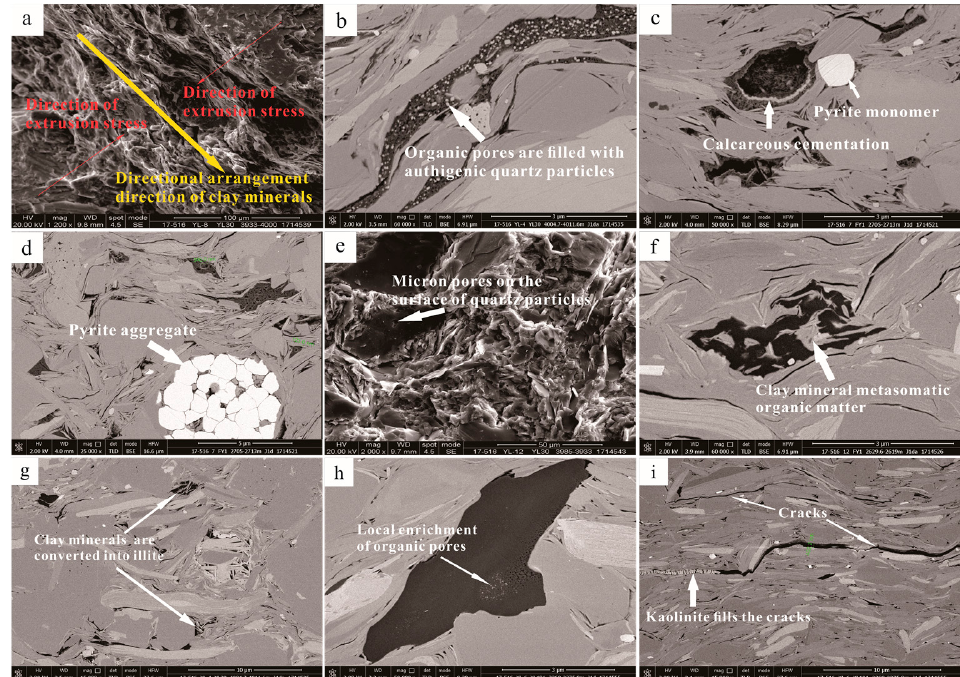
Figure 8. Scanning electron microscope microscopic characteristics of Da’anzhai shale diagenesis. ( a ) Compaction leads to a directional arrangement of clay minerals, Well YL30, 3933 m, Da’anzhai section. ( b ) Organic pores filled with authigenic quartz particles, We YL4, 4004.7 m, Da’anzhai section. ( c ) Calcareous cementation and pyrite monomer, Well FY1, 2705 m, Da’anzhai section. ( d ) Pyrite aggregate, Well FY1, 2705 m, Da’anzhai section. ( e ) Dissolution pores on the quartz particle surface, Well YL30, 3985 m, Da’anzhai section. ( f ) Clay minerals replace organic matter, Well FY1, 2619 m, Da’anzhai section. ( g ) Transformation of clay minerals into illite, Well YL30, 4004.7 m, Da’anzhai section. ( h ) Local enrichment of organic pores formed by hydrocarbon generation of organic matter, Well XL101, 2268 m, Da’anzhai section. ( i ) Microfractures partially filled by kaolinite, Well XL101, 2268 m, Da’anzhai section.